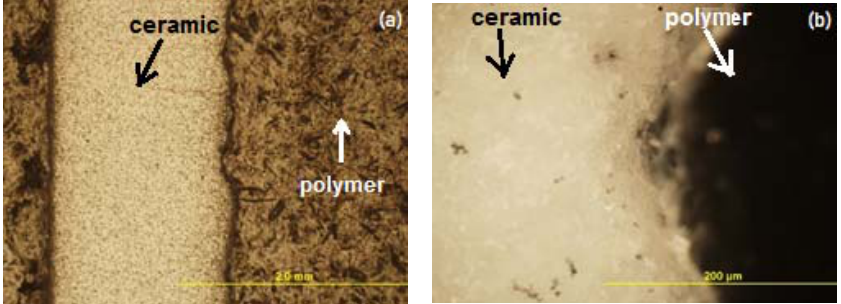
Figure 8. Images of the butt-ends of the fabricated samples using the developed additive printing method: ( a ) 200× magnification image; ( b ) 1000× magnification image. method: ( a ) 200 × magnification image; ( b ) 1000 × magnification